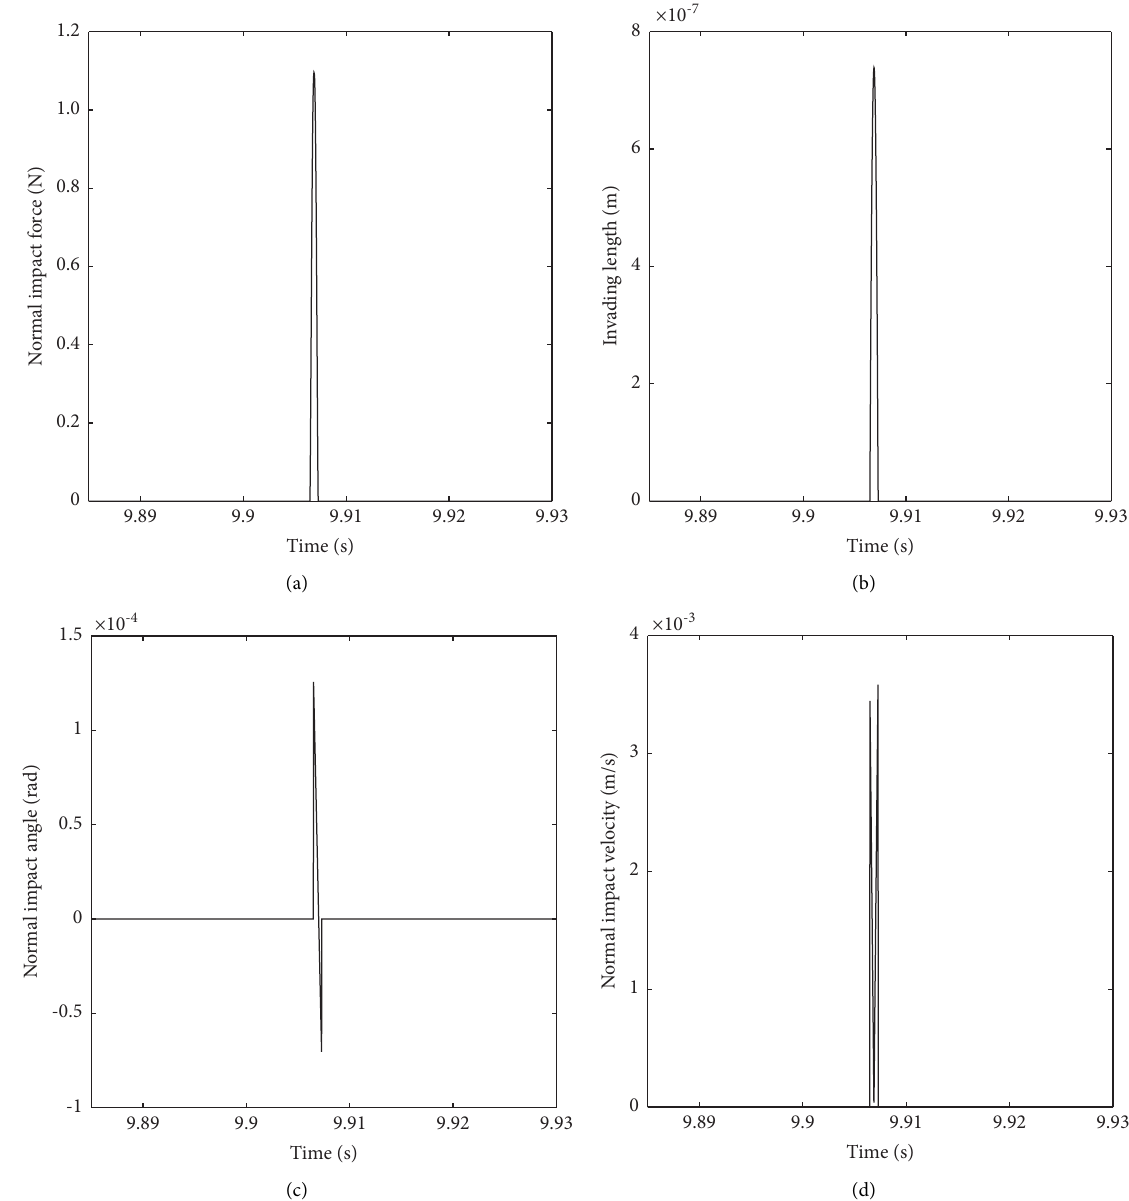
Figure 11: Rubbing process of the MSDS with K angle. (d) Normal impact